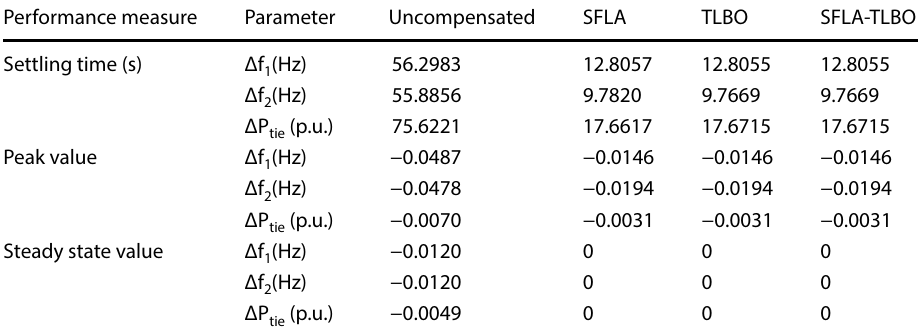
Table 4 Performance analysis for two-area system